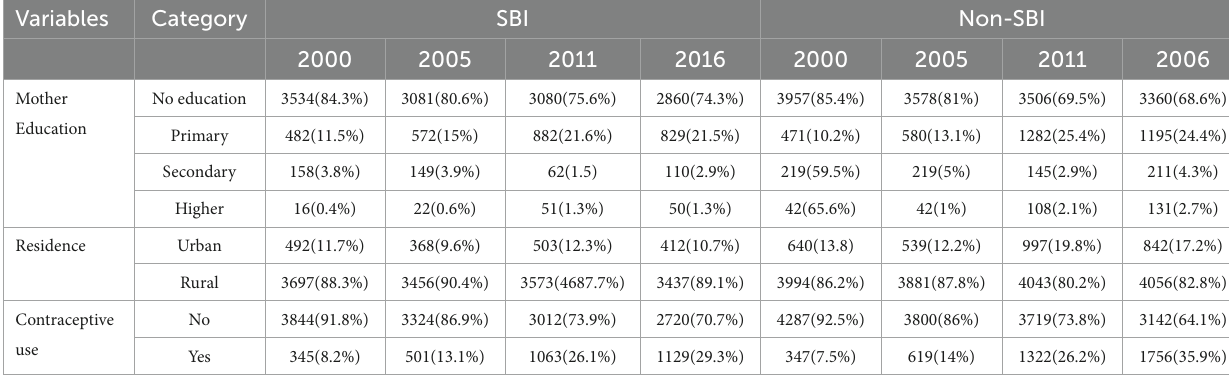
TABLE 1 Factors that affect short birth intervals.